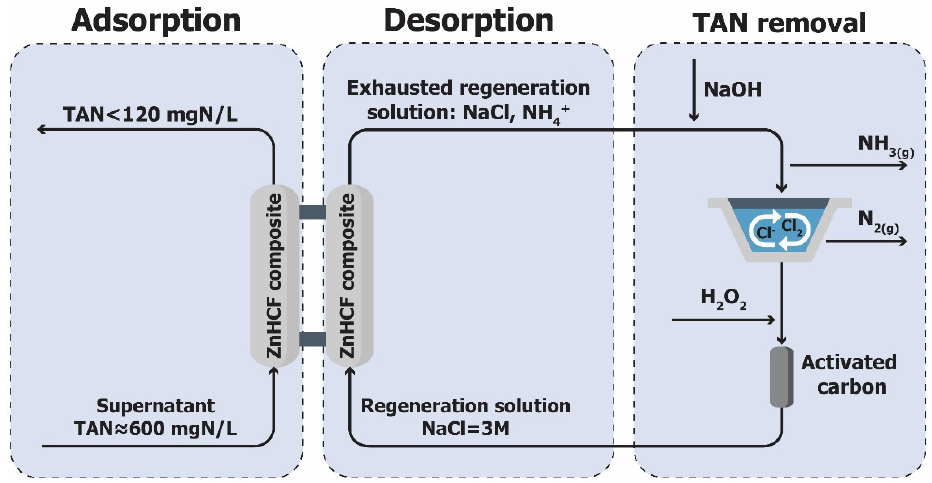
Figure 2. The process scheme, showing the three main steps: (1) adsorption of TAN from the supernatant water to reach an accumulated TAN concentration of ~120 mgN/L; (2) desorption of the ammonium into a regeneration solution to prepare the resin for reuse; and (3) stripping and/or electrochemical indirect oxidation of the desorbed ammonium ions into ammonia gas or benign nitrogen gas (N 2 ), respectively, to treat the exhausted regeneration solution and prepare it for the next regeneration cycle.